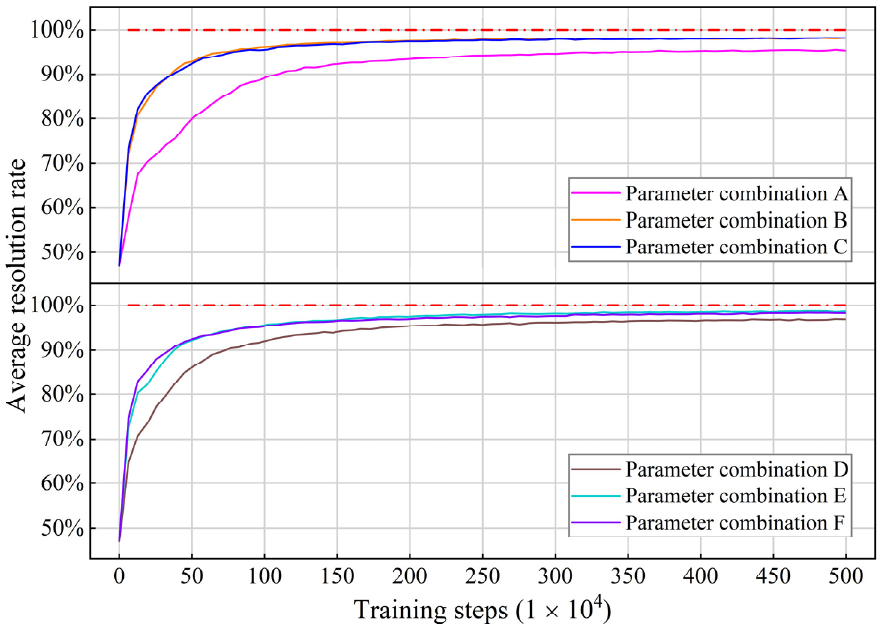
Figure 10. Resolution rate changes with training steps under different parameter combinations.